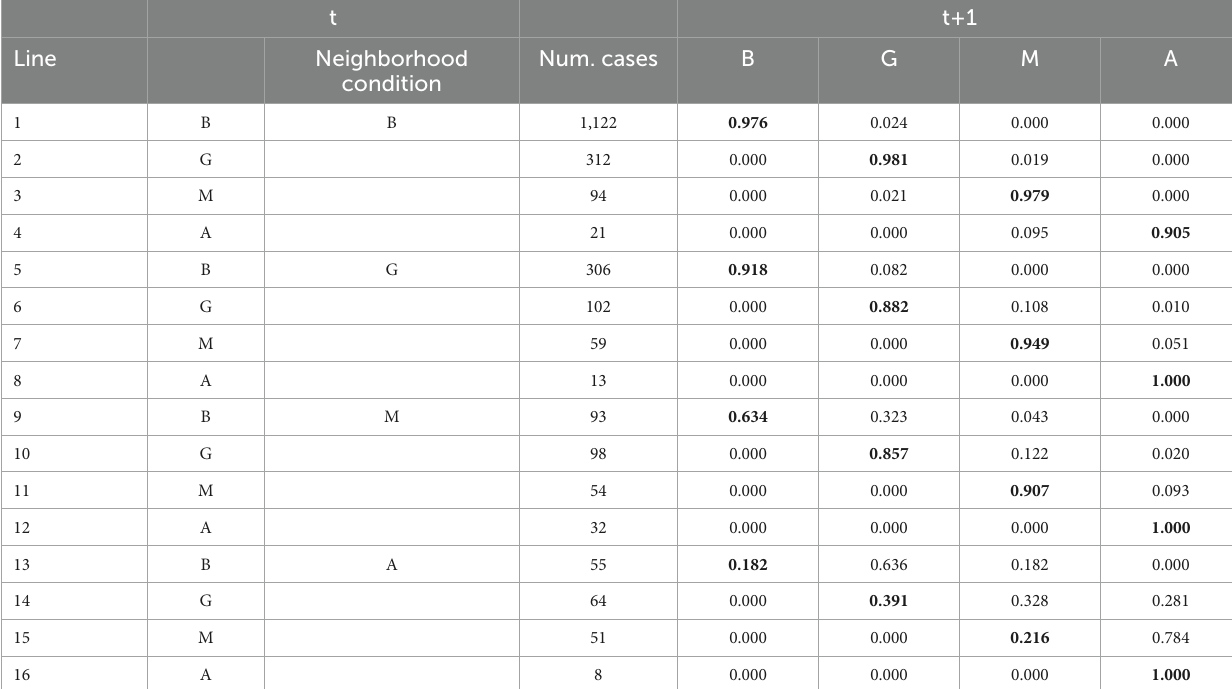
TABLE 7 Spatial Markov